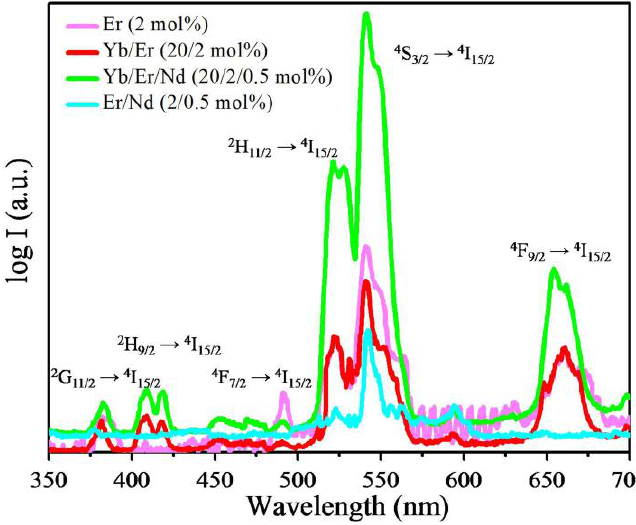
Figure 4. Upconversion emission spectra using a log scale for the emission intensity of NaYF 4 : Er (2 mol%), NaYF 4 : Yb/Er (20/2 mol%), NaYF 4 : Yb/Er/Nd (20/2/0.5 mol%) and NaYF 4 : Er/Nd (2/0.5 mol%) nanoparticles under 808-nm